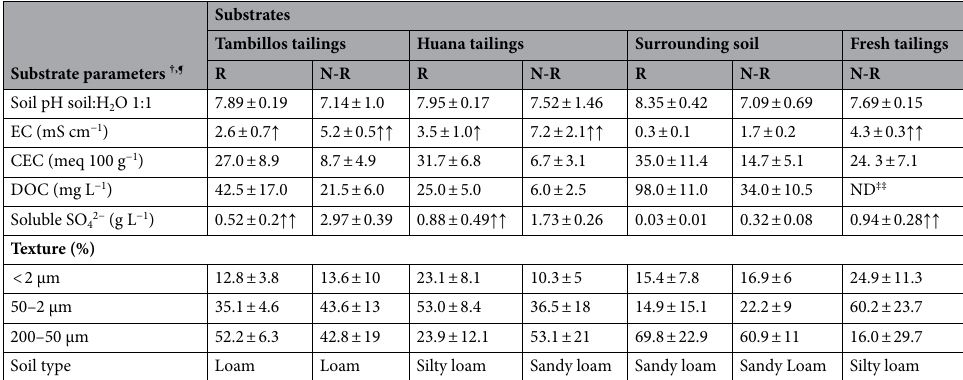
Table 2. Physicochemical characterization of rhizosphere and non-rhizosphere substrates from mine tailings and surrounding soil. R rhizosphere, N-R non-rhizosphere, EC electrical conductivity, CEC cation exchange capacity, DOC dissolved organic carbon. † Values are given as mean and standard error (2–6 replicates). ¶ ↑ High, or ↑↑ very high, according to standard analytical soil parameters. ‡‡ ND: not